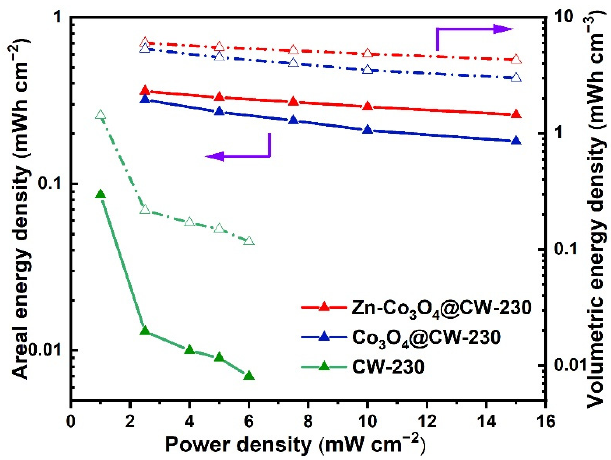
Figure 6. Areal energy density and volumetric energy density at different power densities of the SC of CW-230, Co 3 O 4 @CW-230, and Zn-Co 3 O 4 @CW-230.